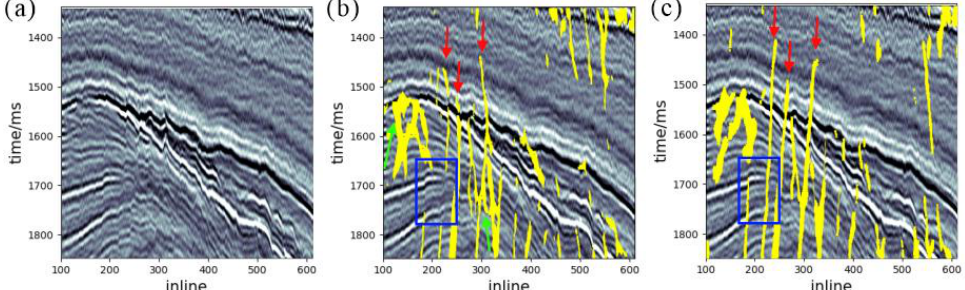
Figure 14. Fault prediction results of Crossline400 longitudinal survey line. ( a ) Seismic profile of Crossline400; ( b ) prediction results of UNet model; ( c ) prediction results of SE-UNet model.